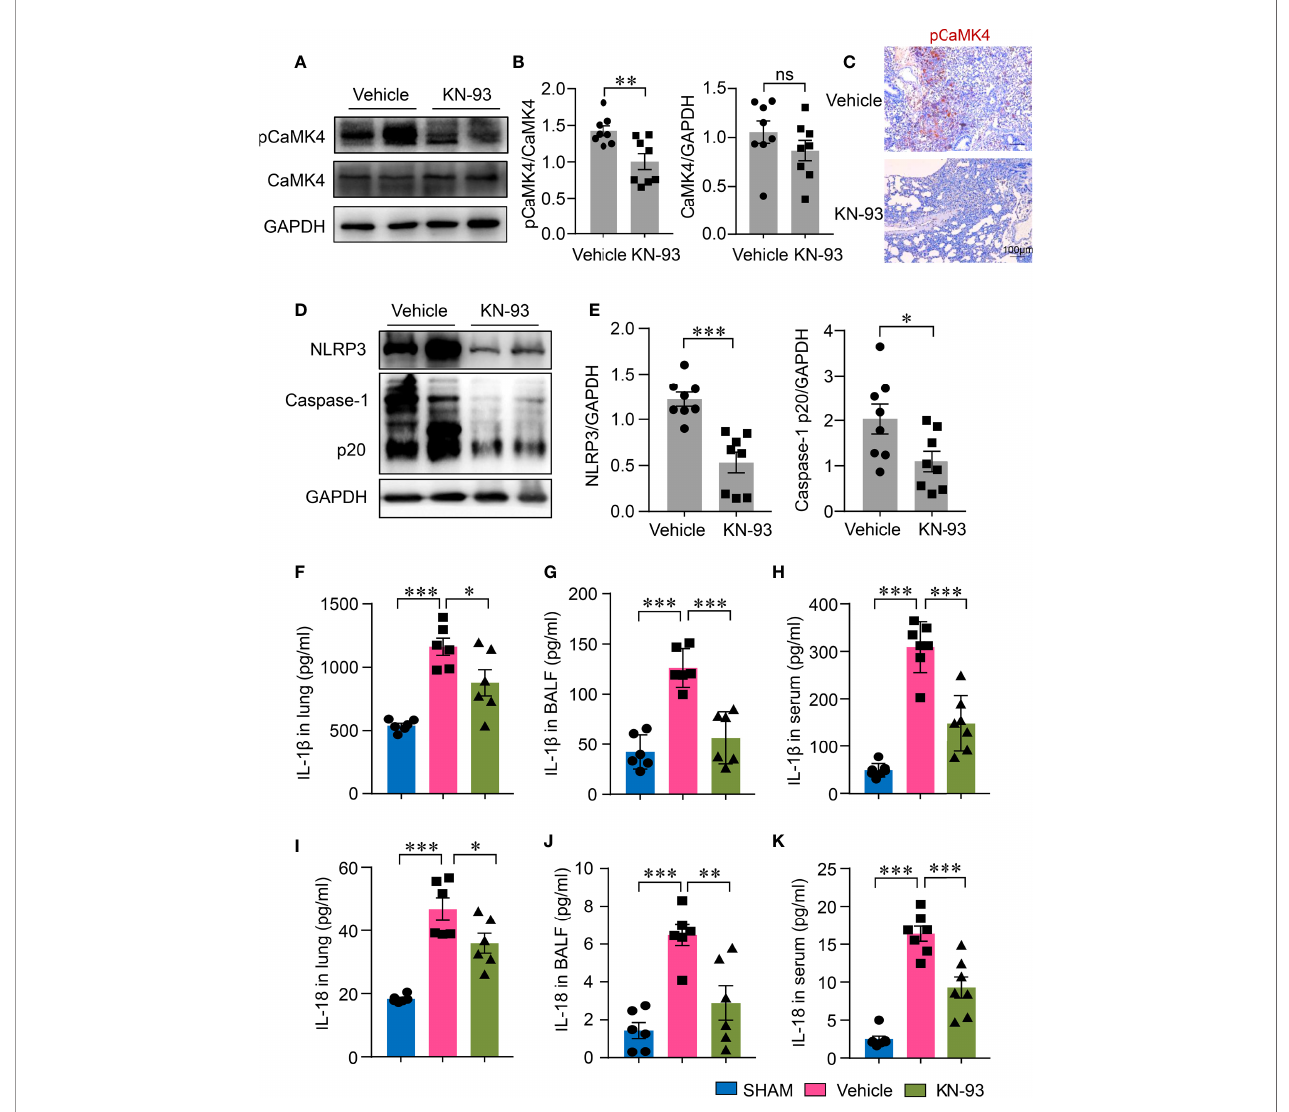
FIGURE 2 | KN-93 inhibited the activation of NLRP3 in fl ammasome in ALI. ALI mice were induced as described in Fig. 1 and treated with KN-93 (10mg/kg) or vehicle. (A, B) Expressions of pCaMK4 and CaMK4 in the lung tissues from KN-93 or vehicle treated mice were measured by Western blot. Representative bands were shown. Relative expression of pCaMK4 was quanti fi ed. (C) Immunohistochemical staining of pCaMK4 in lung tissues from KN-93 or vehicle treated mice. Representative images were shown. Scale bar: 100 m m. (D, E) NLRP3, Caspase-1 p20 and GAPDH in the lung from KN-93 or vehicle treated mice were measured by Western blot. Representative bands were shown and relative expression of NLRP3, Caspase-1p20 to GAPDH were summarized. (F – K) IL-1 b and IL-18 in lung tissues, bronchoalveolar lavage fl uid (BALF) and sera from KN-93 or vehicle treated mice were measured by ELISA. All data are mean± SEM. *p < 0.05, **p < 0.01, ***p < 0.0001. ns, not signi fi